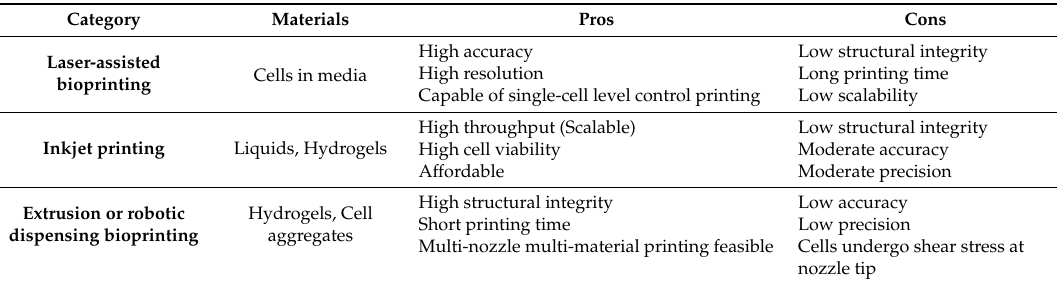
Figure 1. Three main bioprinting technologies: ( a ) Laser-assisted bioprinting; ( b ) Inkjet printing; ( c ) Extrusion or robotic dispensing bioprinters (adapted from Reference [3]). Table 2. Categories of Bioprinting Technologies.